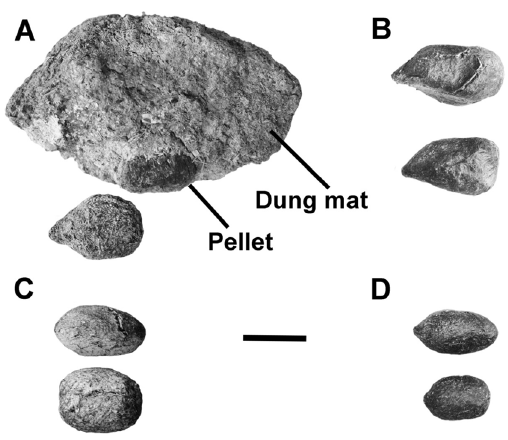
Figure 2. Dung from Mojet Cave and recent potential dung producers. A) dung pellet and mat (ETVP 4999) from Mojet Cave; identified as bighorn sheep, Ovis canadensis (see text). Note pellet in dung mat is featured below after removal. Opposite side of dung mat has a thin layer of bat guano adhering to the surface. Recent dung: B) bighorn sheep, Ovis canadensis (ETVP 6083); C) pronghorn antelope, Antilocapra americana (ETVP 6028); D) mule deer, Odocoileus hemionus (ETVP 6017). Scale bar equals 10